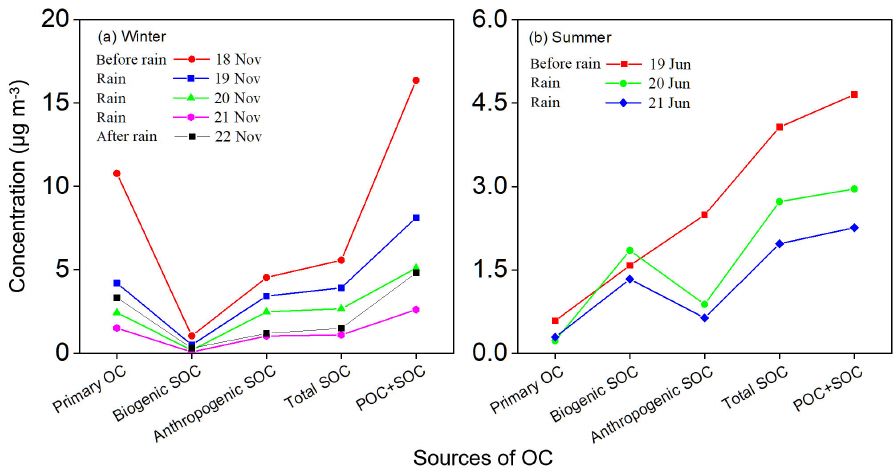
Figure 12. The concentration changes of primary and secondary OC during (a) winter- and (b) summertime on fine and rainy days.